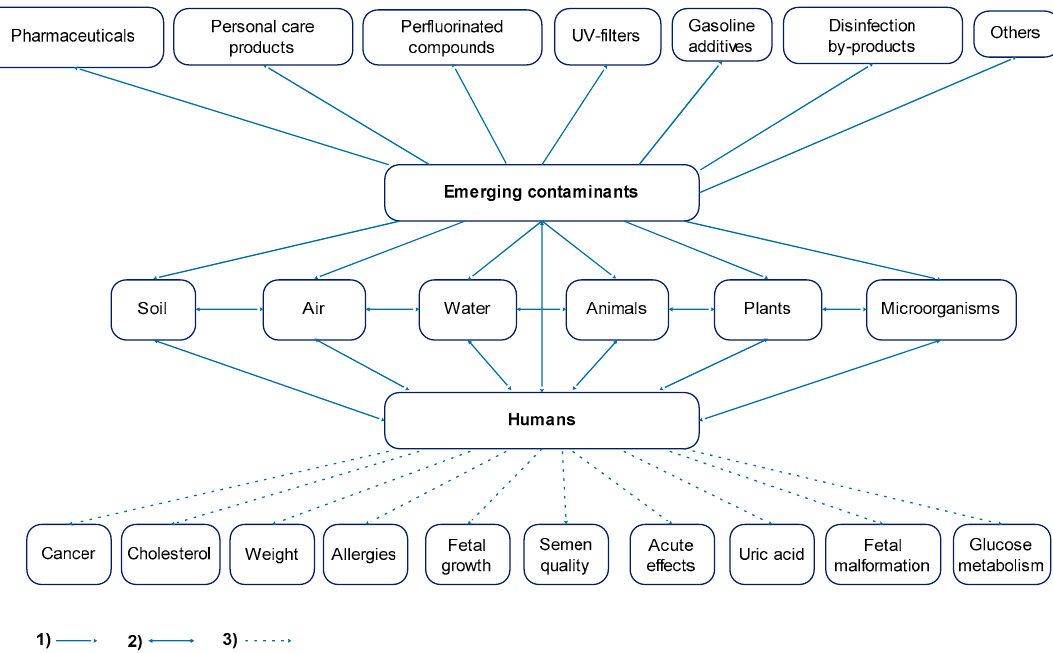
Figure1. ( 1 )Theimpactofmicropollutantsinsoil, air, water, animals, plants, andmicroorganisms; ( 2 )the Figure 1. ( 1 ) The impact of micropollutants in soil, air, water, animals, plants, and microorganisms; interactions between them; and ( 3 ) the potential adverse e ff ects of human exposure to micropollutants ( 2 ) the interactions between them; and ( 3 ) the potential adverse effects of human exposure to and their sources (Adapted from micropollutants and their sources (Adapted from [3]).